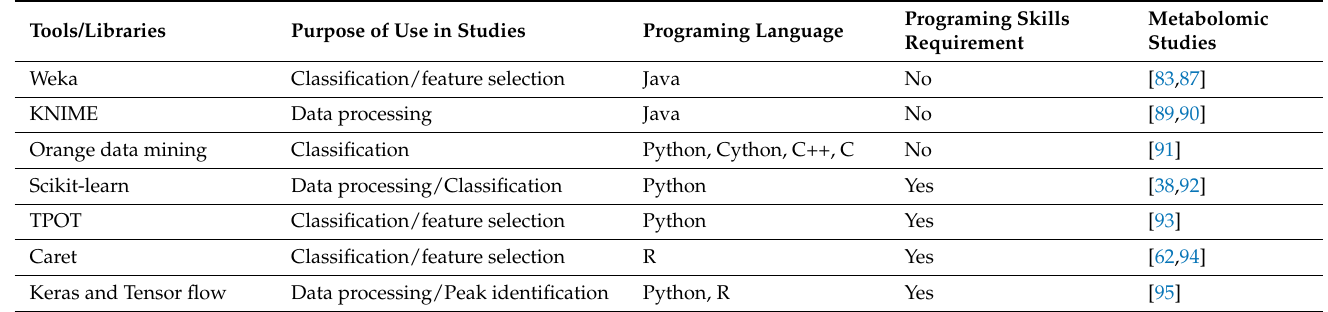
Tools and libraries used by metabolomics studies for the application of machine learning